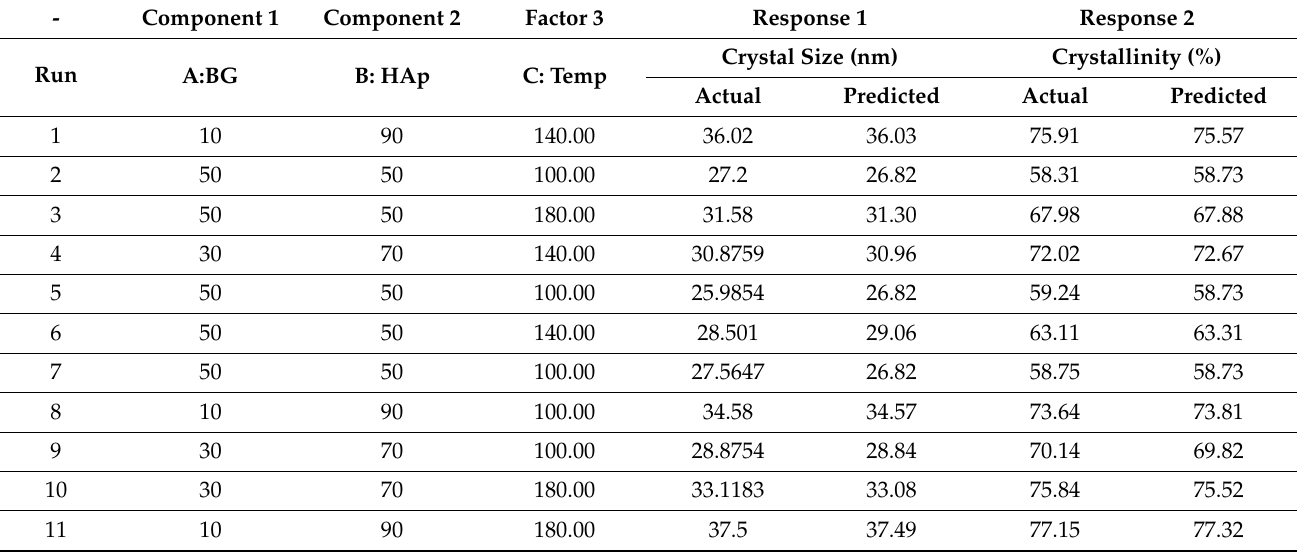
Table 6. DOE predictions vs. values determined by